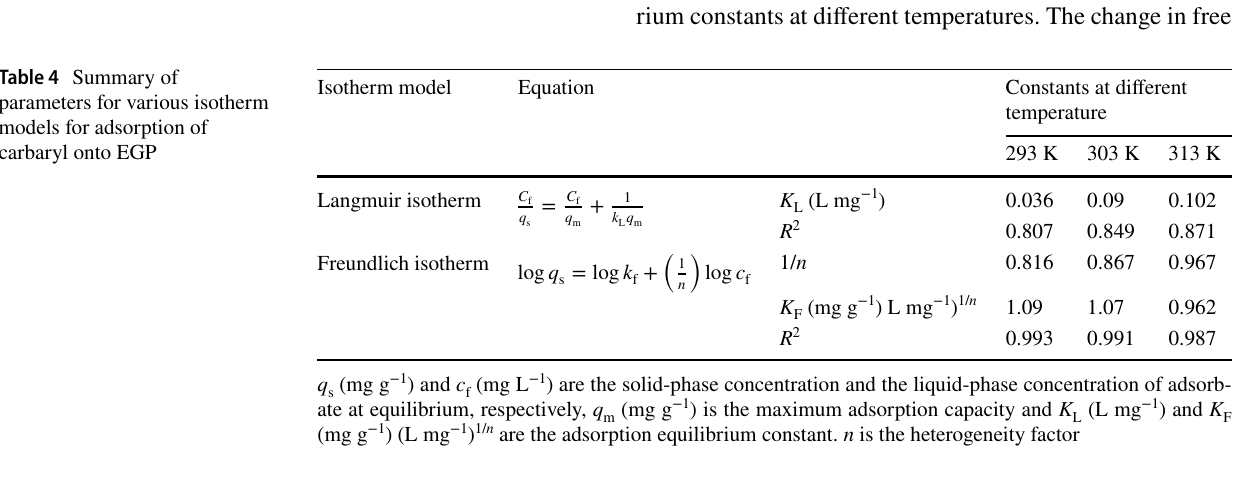
Table 5 Summary of parameters for various kinetic models for adsorption of carbaryl onto EGP